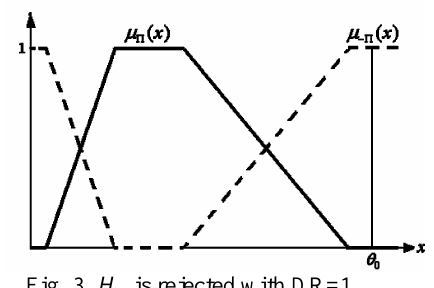
Fig. 3. H is rejected with DR=1. 0